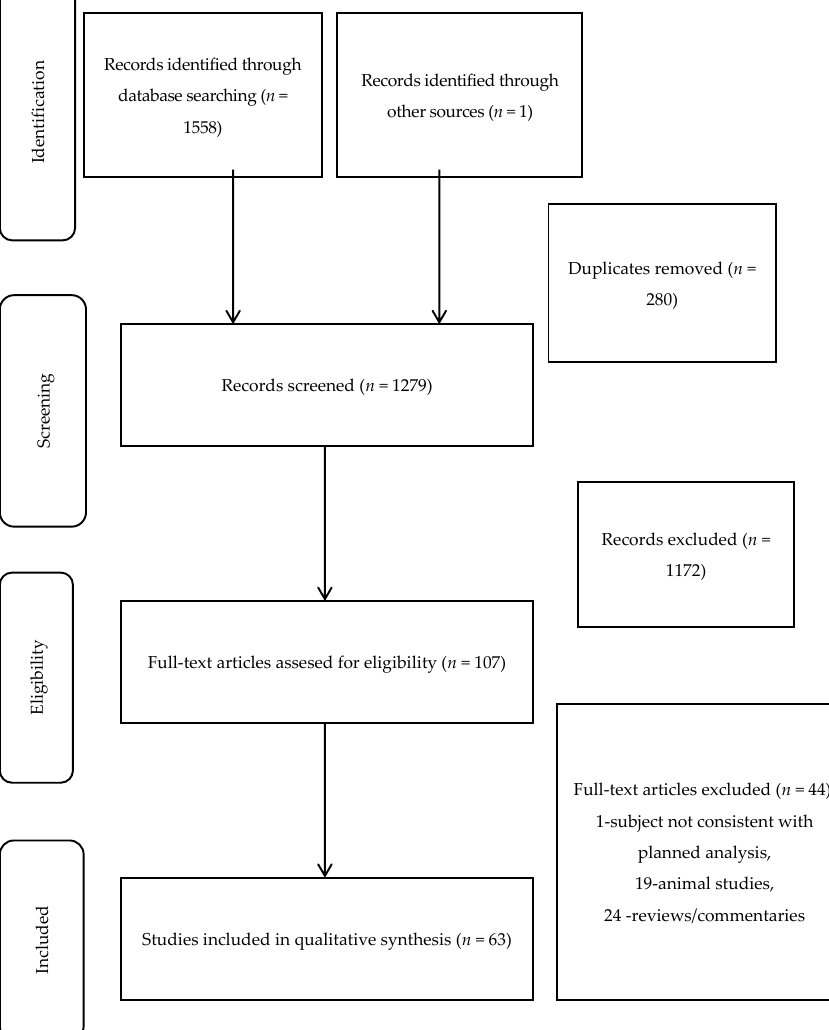
Figure 2. Search strategy and results.